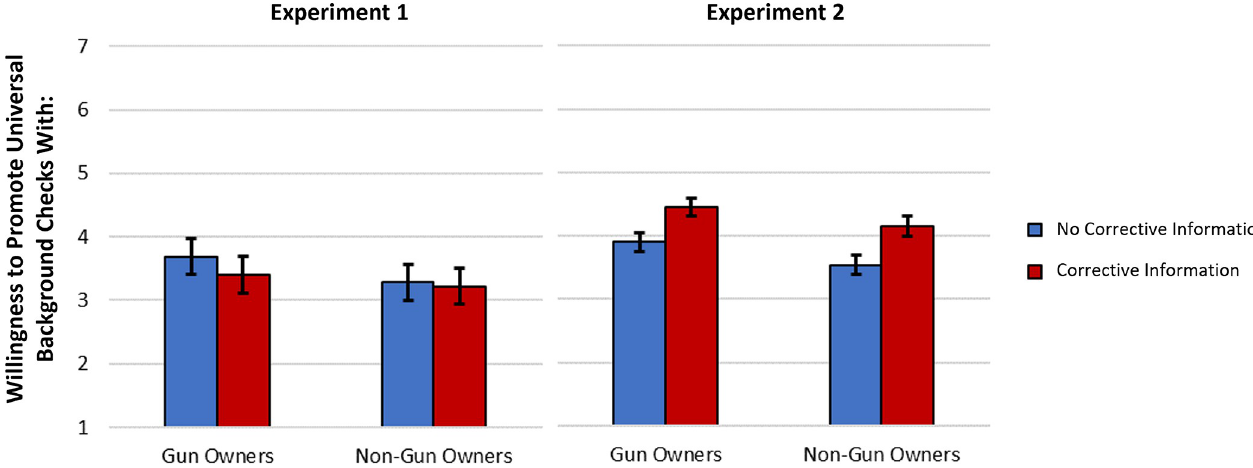
Fig 2. Willingness to promote universal background checks with gun and non-gun owners as a function of group and corrective information condition. Data from Experiments 1 ( N = 195 gun owners) and 2 ( N = 696 gun owners). Error bars represent 95% confidence intervals.